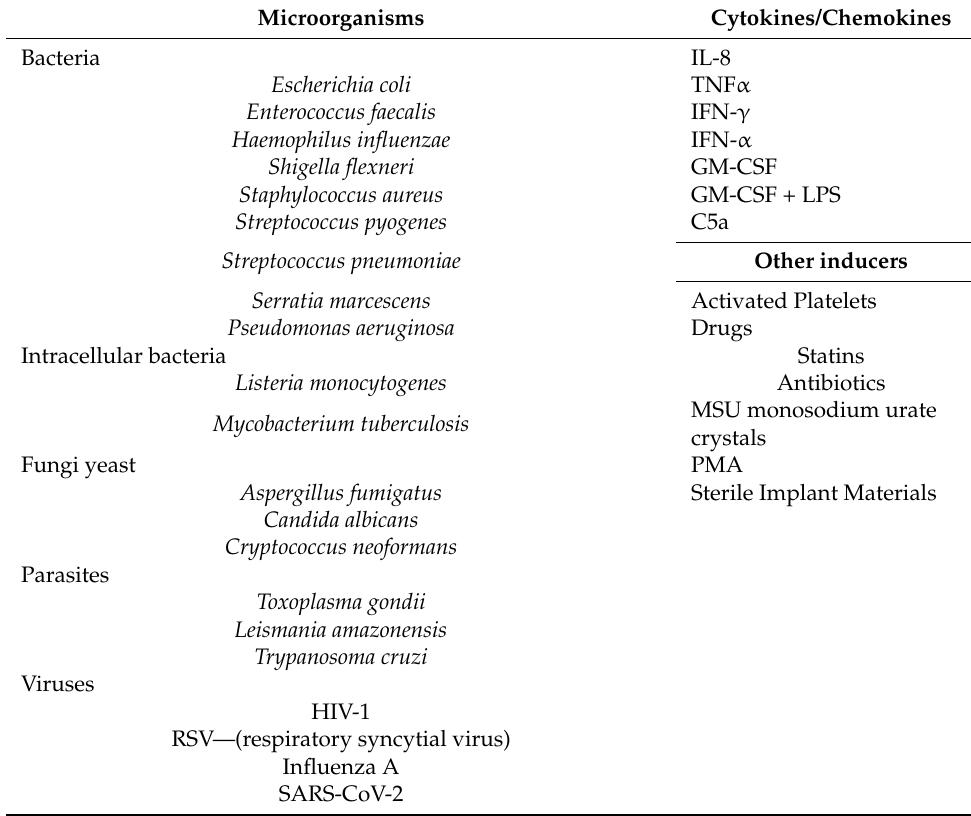
Table 1. NET inducers. tnterleukin 8 (IL-8), tumor necrosis factor - α (TNF α ), interferon- γ (IFN- γ ), interferon- α (IFN- α ), granulocyte-macrophage colony-stimulating factor (GM-CSF), lipopolysaccha- rides (LPS), and complement component 5a